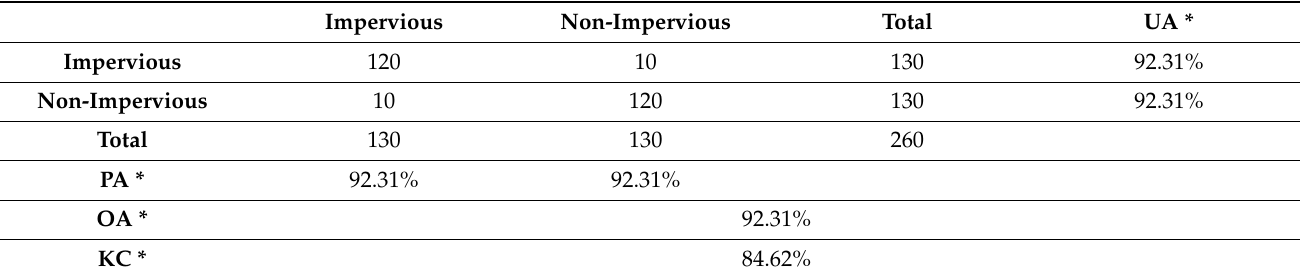
Table 4. Confusion matrix of the RF classification result.